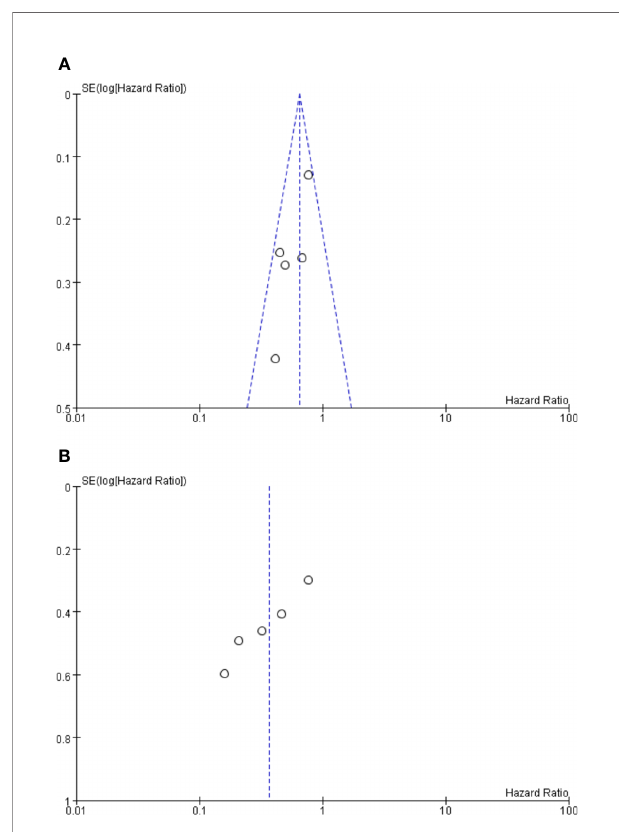
FIGURE 6 | (A) Funnel plot analysis of potential publication bias for PFS. (B) Funnel plot analysis of potential publication bias for